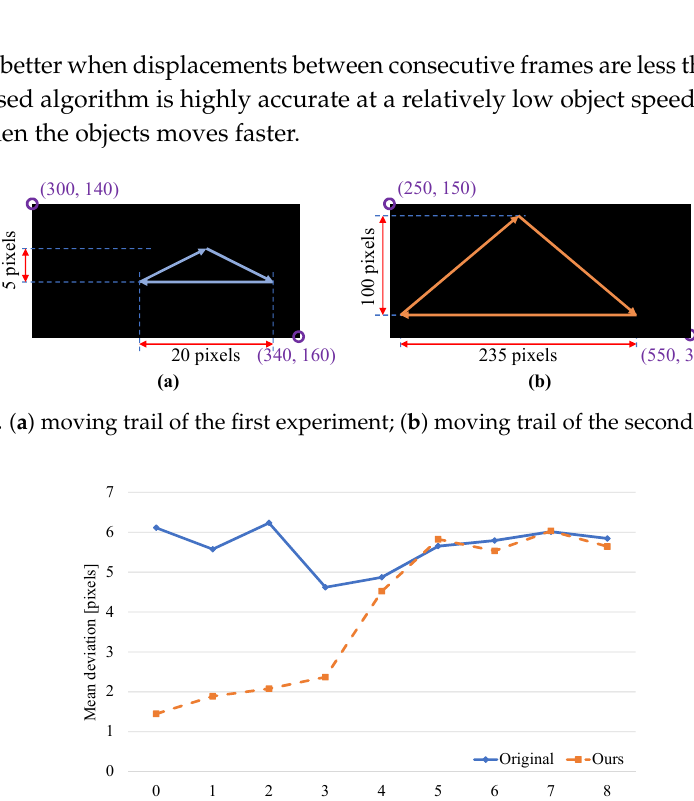
Figure 17. Mean deviations for different object displacements between